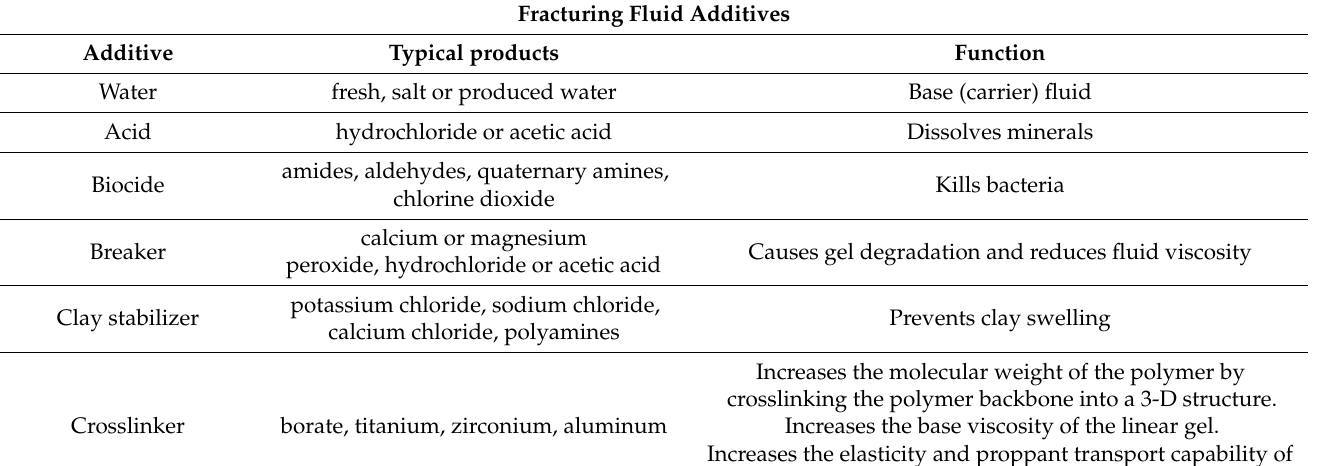
Table 12. Fracturing fluid